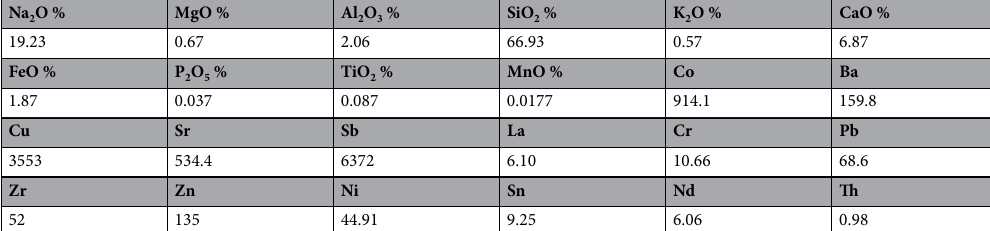
Table 1. Chemical composition of the bead. Data are in wt % where marked with the percent sign, or in ppm when